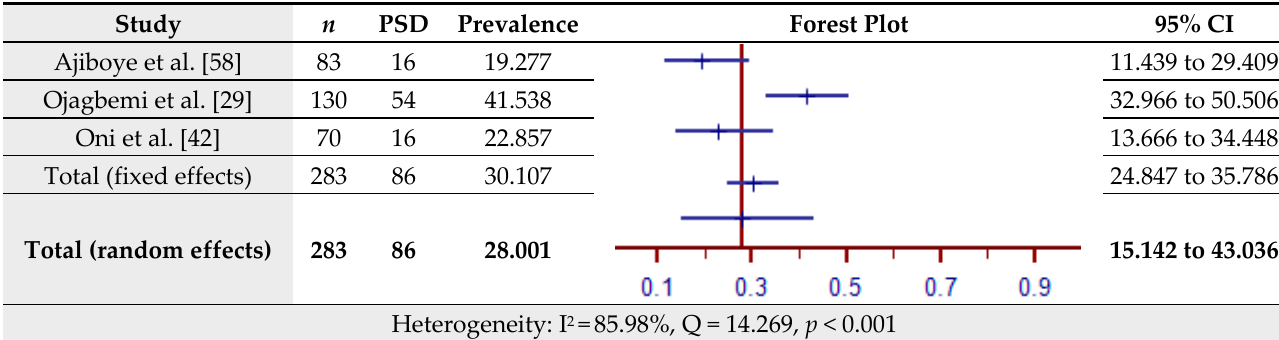
Figure 6. Prevalence estimates of Post-Stroke Depression (PSD) assessed by the Schedules for Clinical Assessment in Neuropsychiatry (SCAN).